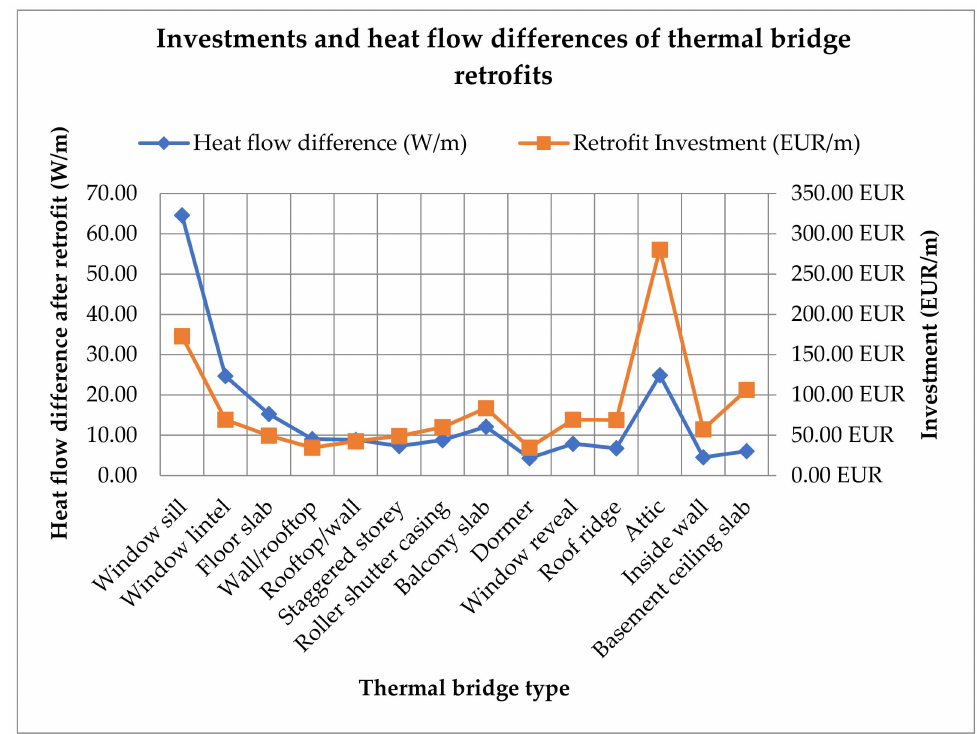
Figure 5. Costs and heat flow differences of the retrofit of 14 thermal bridge types of German buildings constructed between 1950 and 1969.